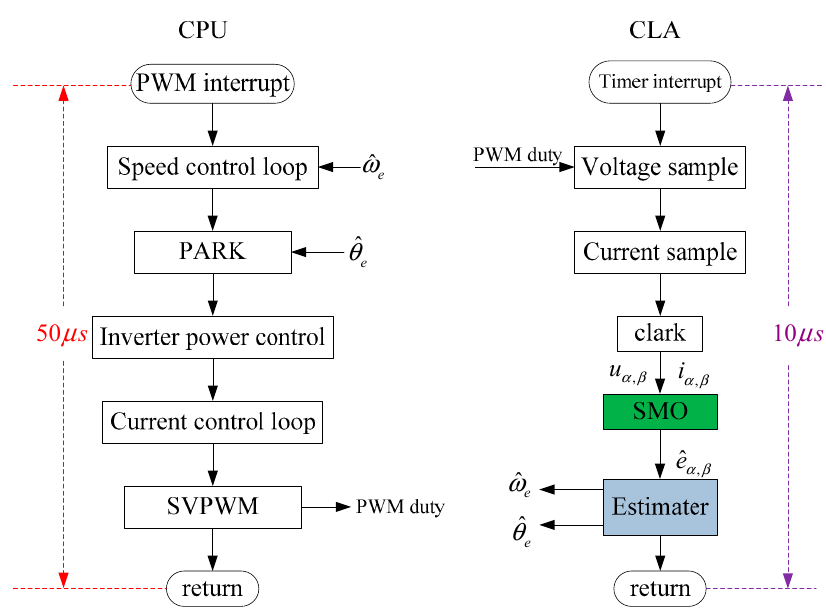
Figure 7. Block diagram of the implemented digital signal processor (DSP) algorithm.